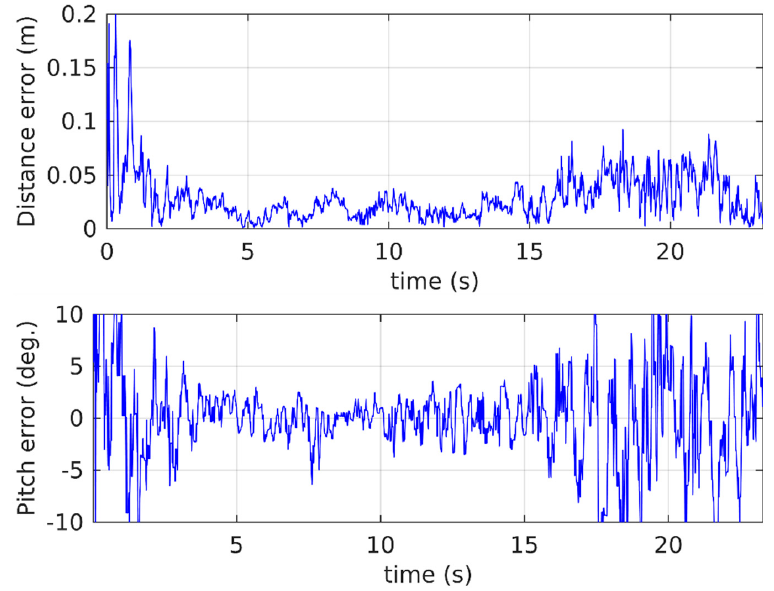
Figure 12. Path and pitch angle errors, poor shielding: σ = 8 μ T.